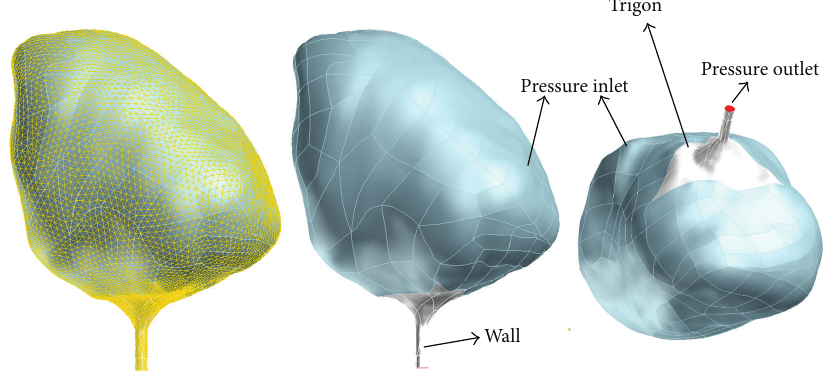
Figure 2: Three-dimensional (3D) urinary bladder reconstructions using MIMICS.